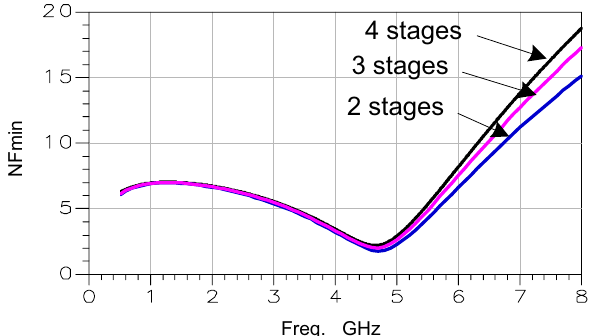
Figure 5. Noise comparison for different number of